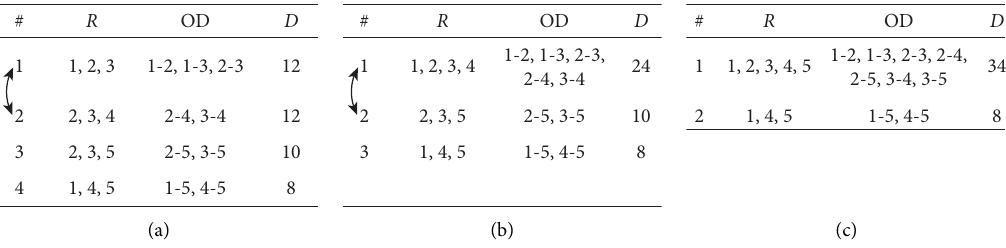
Figure 5: Illustration of combination procedure. (a) Route 1+ 6. (b) New route 1+2. (c)